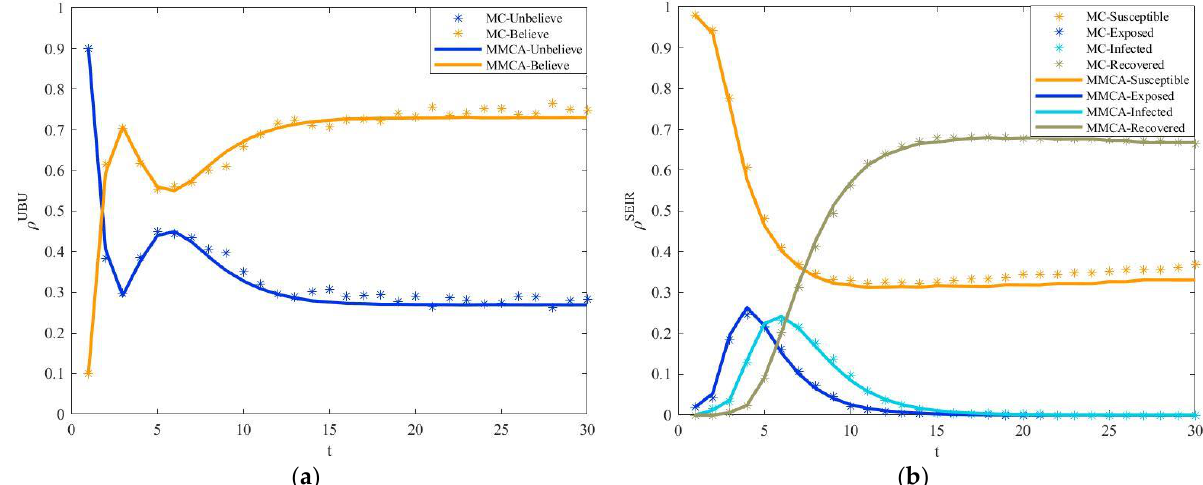
Figure 5. ( a ) Enterprise proportion of U, B states as a function of the time step t ; ( b ) Enterprise proportion of S, E, I, and R states as a function of the time step t . The model parameters are set as follows: p = 0.3, q = 0.25, α = 5, m = 2, m 1 = 5, m 2 = 7, κ = 2, β = 0.9, η = 0.6, µ = 0.5, λ = 0.5, δ = 0.3, γ = 0.5, θ = 0.